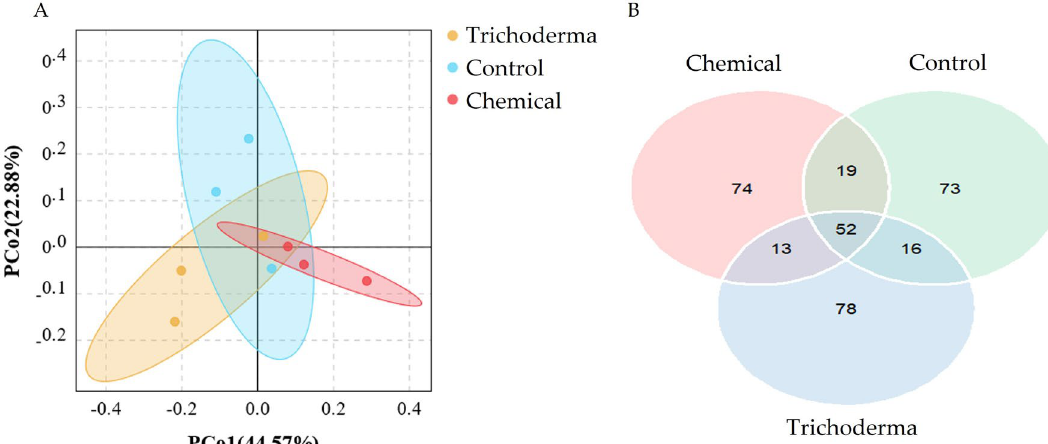
Figure 2. OTU composition analysis of wheat rhizosphere soil under the conditions of control seed dressing (Control), chemical fungicide seed dressing (Chemical) and T. atroviride HB20111 seed dressing ( Trichoderma ). Principal component analysis ( A ) and Venn distribution diagram ( B ).